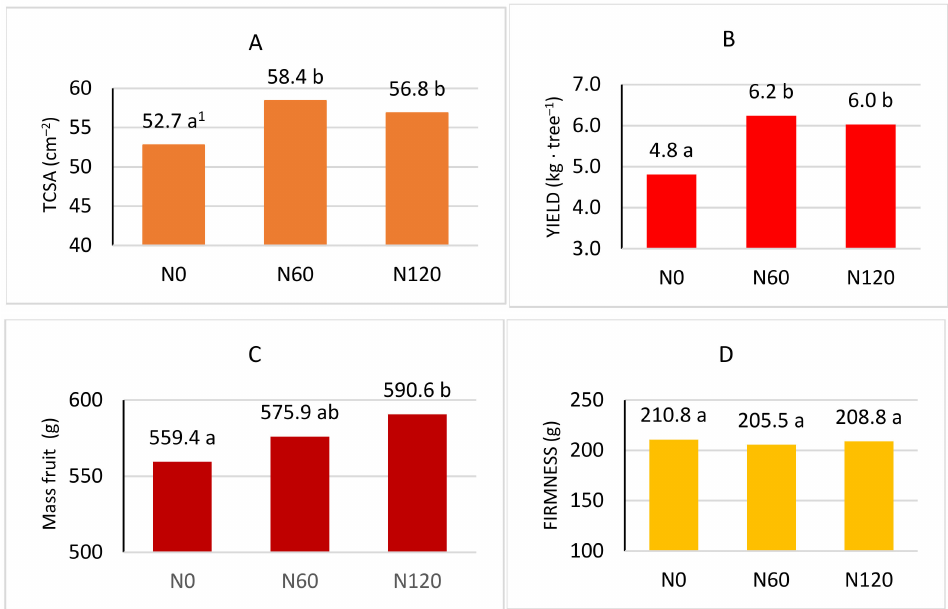
Figure 12. The effect of nitrogen fertilization on ( A )—tree cross sectional area (TCSA) (cm − 2 ), ( B )—yield (kg tree − 1 ), ( C )—mass of fruit (g), ( D )—firmness of fruit (g). Average for all orchards (OR 1, OR 2, OR 2) in years 2007–2013. 1 means that the same letters are not significantly different at α = 0.05 (Duncan’s